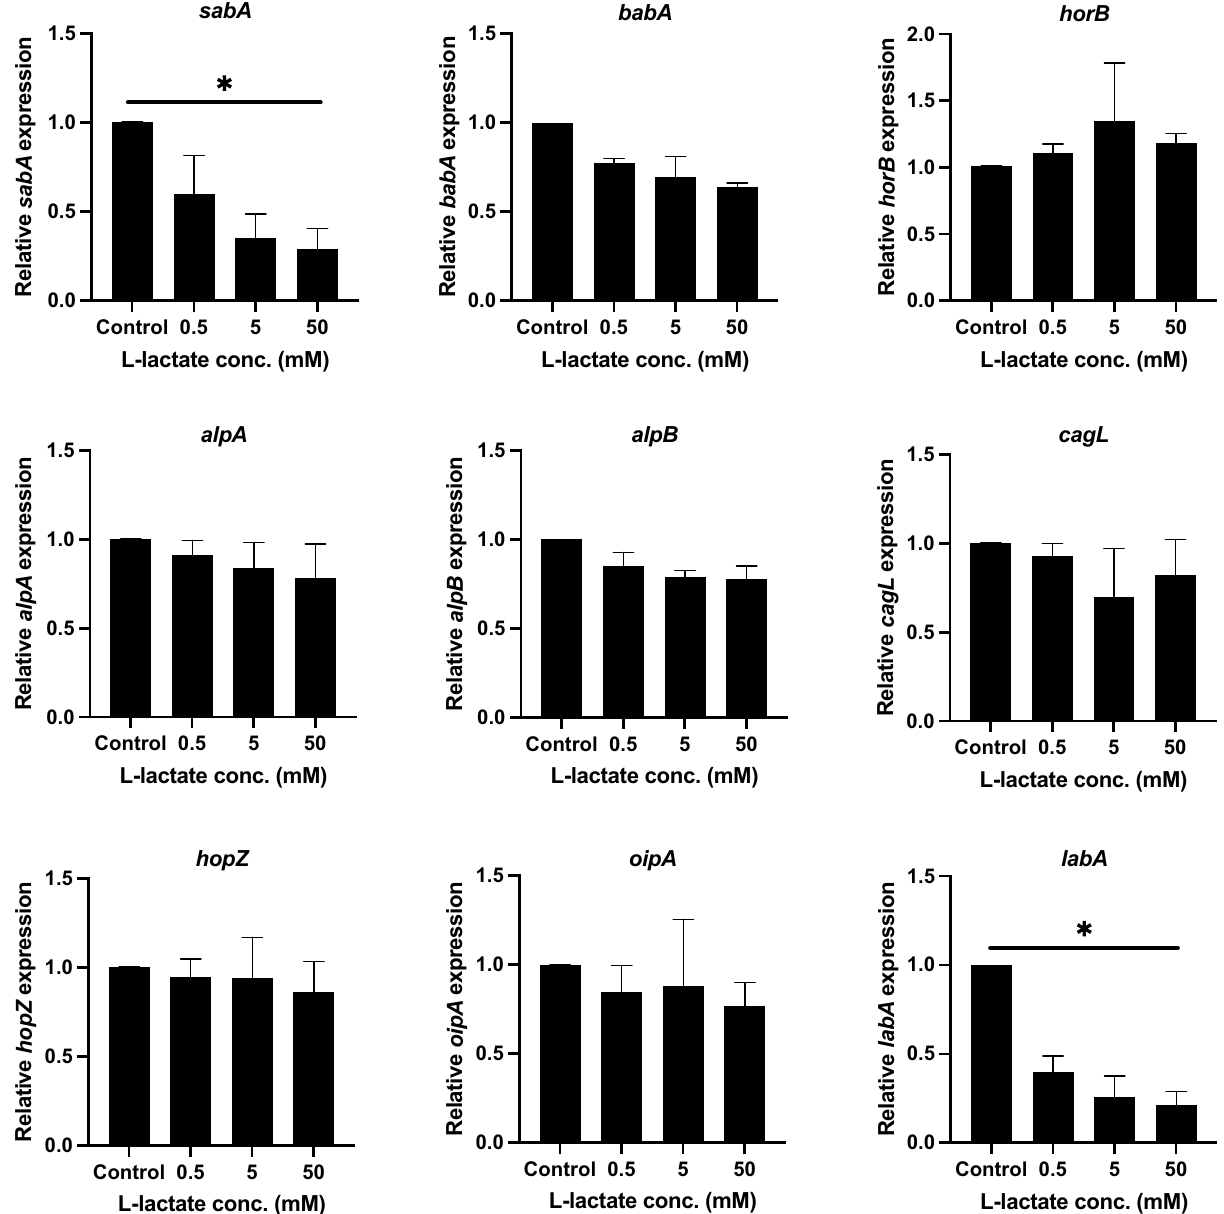
Figure 1. l-lactate inhibits sabA and labA expression in H. pylori. Gene expression of H. pylori adhesins after incubation of the bacteria in RPMI 1640 medium without glucose (control) or supplemented with various concentrations of l-lactate. The mRNA expression levels of various H. pylori adhesin genes were quantified using qPCR after 2 h. Target mRNA levels were normalized to those of the housekeeping gene gyrB . Gene expression levels in the control were set to 1. Data represent the means and standard deviation of duplicate samples and are average of three independent experiments. *P < 0.05; ns, nonsignificant, using ANOVA followed by a Bonferroni